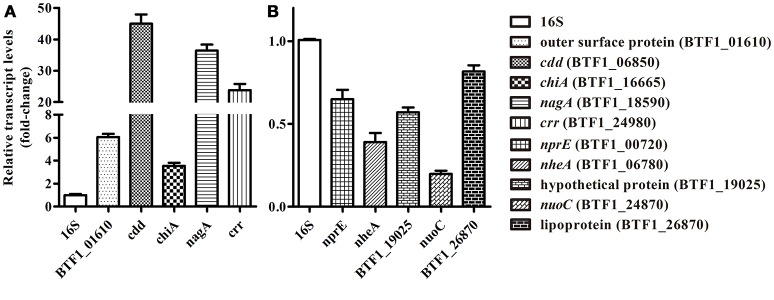
qRT-PCR validation of RNA-seq data. (A) Five DEGs that showed increased expression were selected randomly, namely BTF1_01610 (outer surface protein), BTF1_06850 (cdd), BTF1_16665 (chiA), BTF1_18590 (nagA), and BTF1_24980 (crr). (B) Five DEGs that showed decreased expression were selected randomly, namely BTF1_00720 (nprE), BTF1_06780 (nheA), BTF1_19025 (hypothetical protein), BTF1_24870 (nuoC), and BTF1_26870 (Lipoprotein).